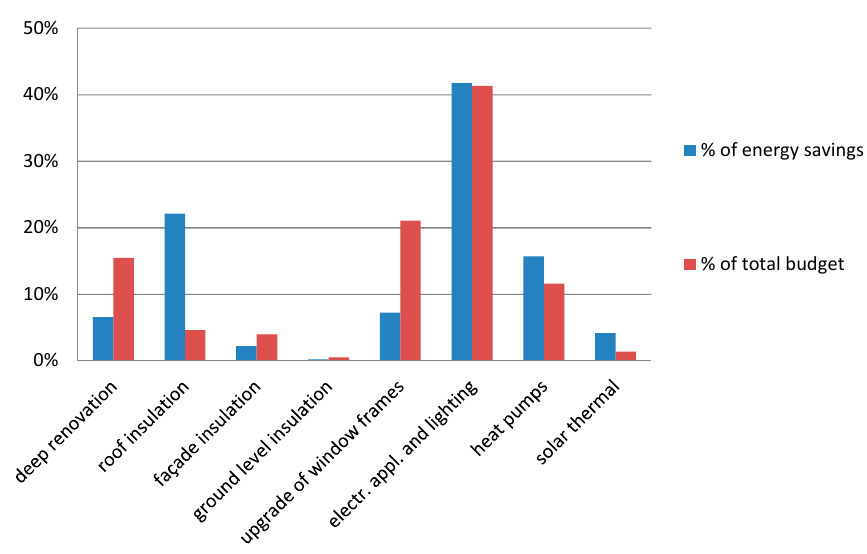
Figure 3. Contribution of energy renovations in multi-family buildings to total costs and total energy savings.